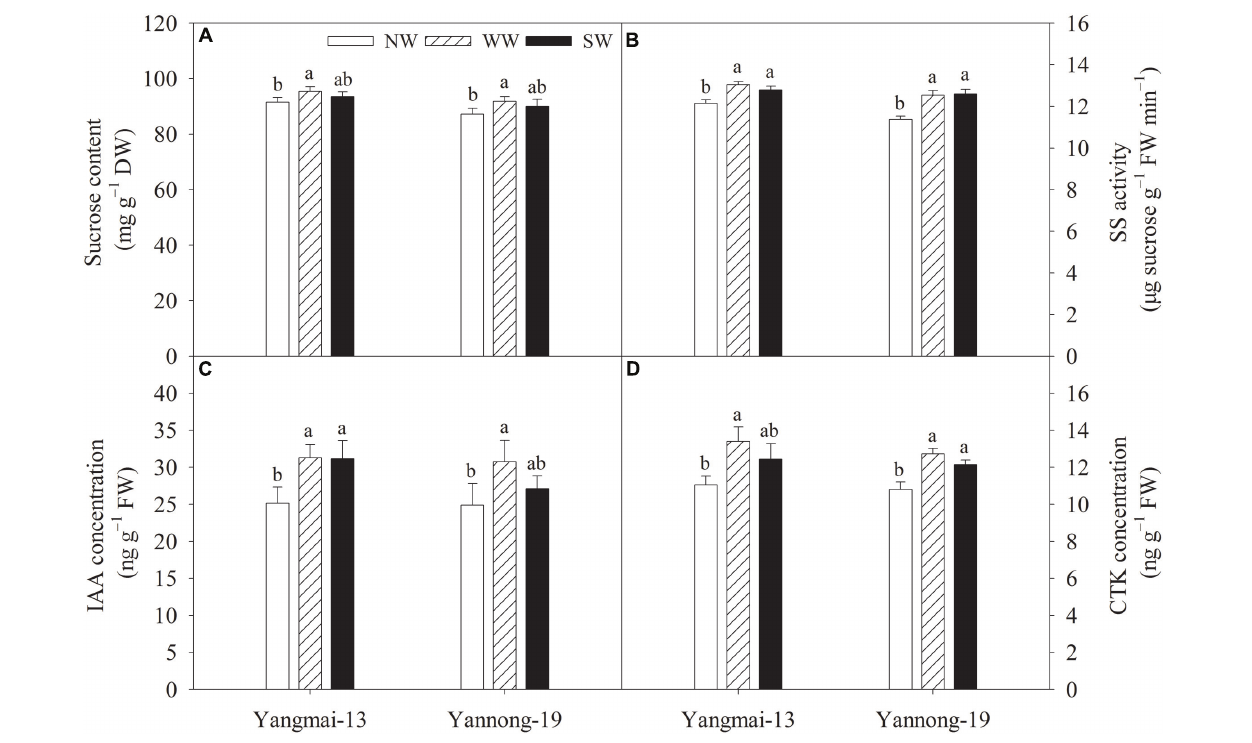
FIGURE 7 | Grain sucrose content (A) , sucrose synthase (SS) activity (B) , indole-3-acetic acid (IAA) concentration (C) and cytokinin (CTK) concentration (D) of Yangmai-13 and Yannong-19 at the grain-filling stage as affected by winter (WW) and spring (SW) night-warming during 2013–2014. NW refers to the no warming control. Lowercase letters refer to significant differences between treatments ( P < 0.05). Whiskers on the top of the bars indicate the standard error ( n = 3). TABLE 2 | Grain-filling rate of Yangmai-13 and Yannong-19 as affected by winter (WW) and spring (SW) night-warming during 2012-2014.